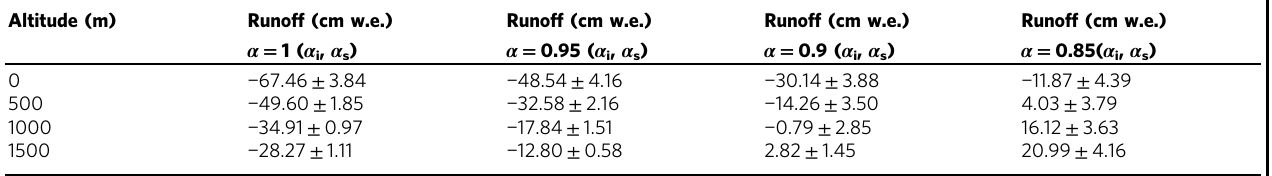
Table 2 Modeled change in runoff in response to a summer high-latitude eruption with unchanged SWRF Altitude (m) Runoff (cm